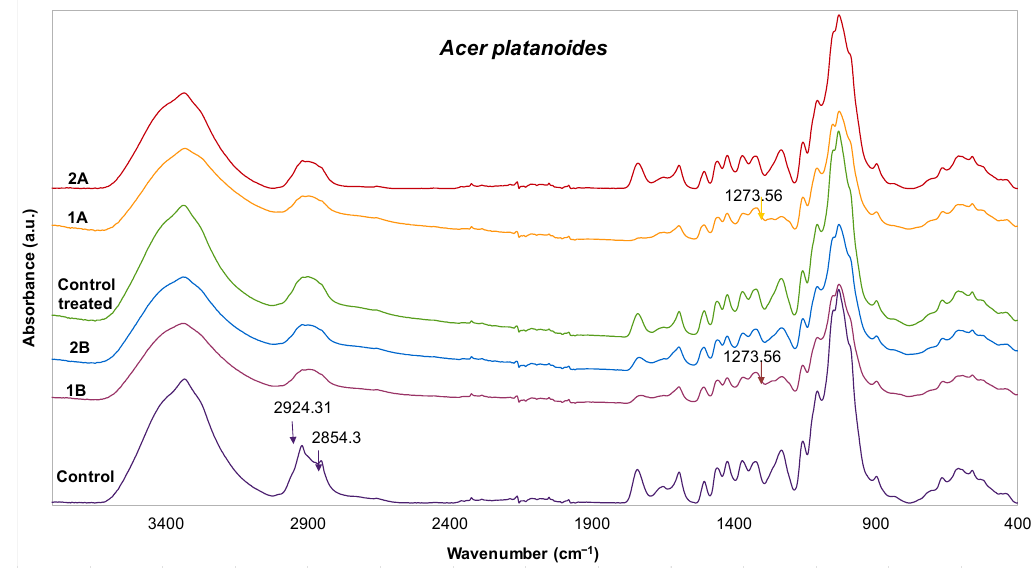
Figure 2. Spectral band assignments of the main spectral peaks observed in the Norway maple wood FTIR spectra. 1A—